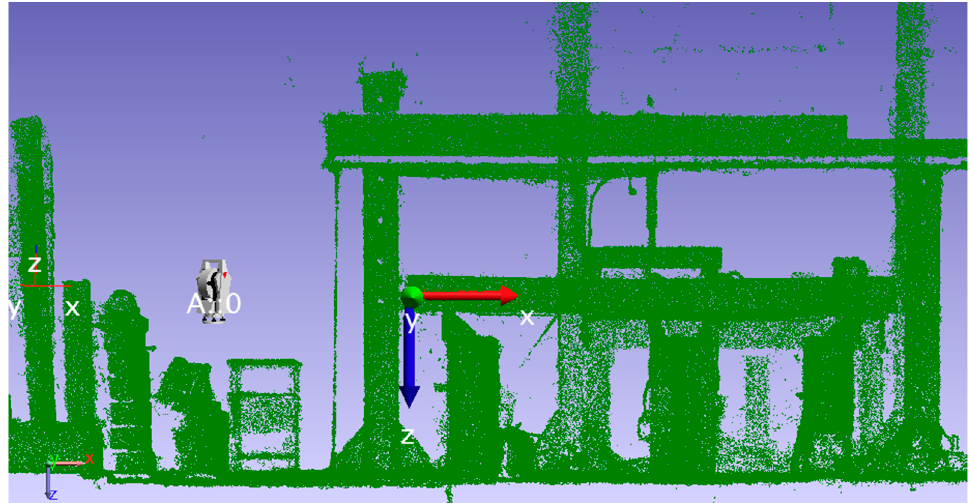
Figure 7. The reference system on the beam.